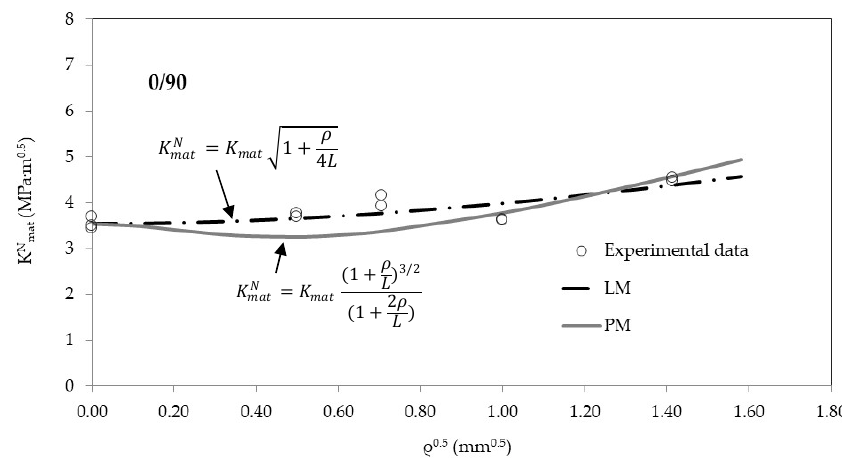
Figure 4. Apparent fracture toughness experimental results in 0 / 90 raster orientation. Best fit curves provided by the point method (PM) and line method (LM).